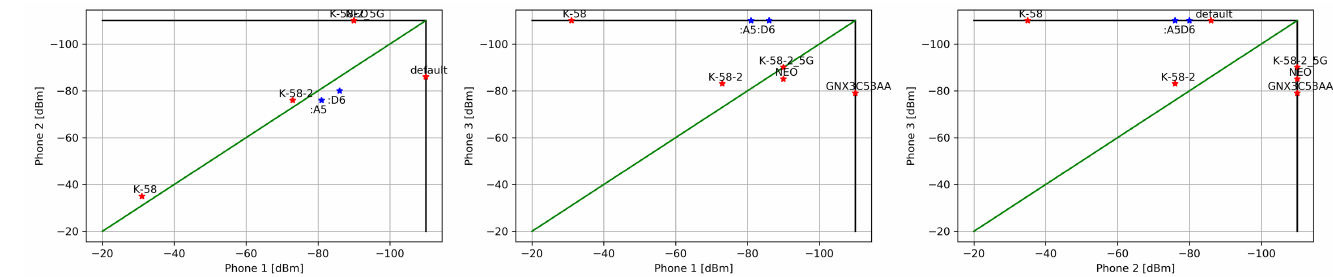
Figure 3. Graphical presentation of phone proximity based on the radio environment. Red stars denote WiFi RSSI measurements, blue stars Bluetooth measurements, and the green line indicates the same signal from both phones. The − 110 dBm RSSI level denotes the access points out of the terminal